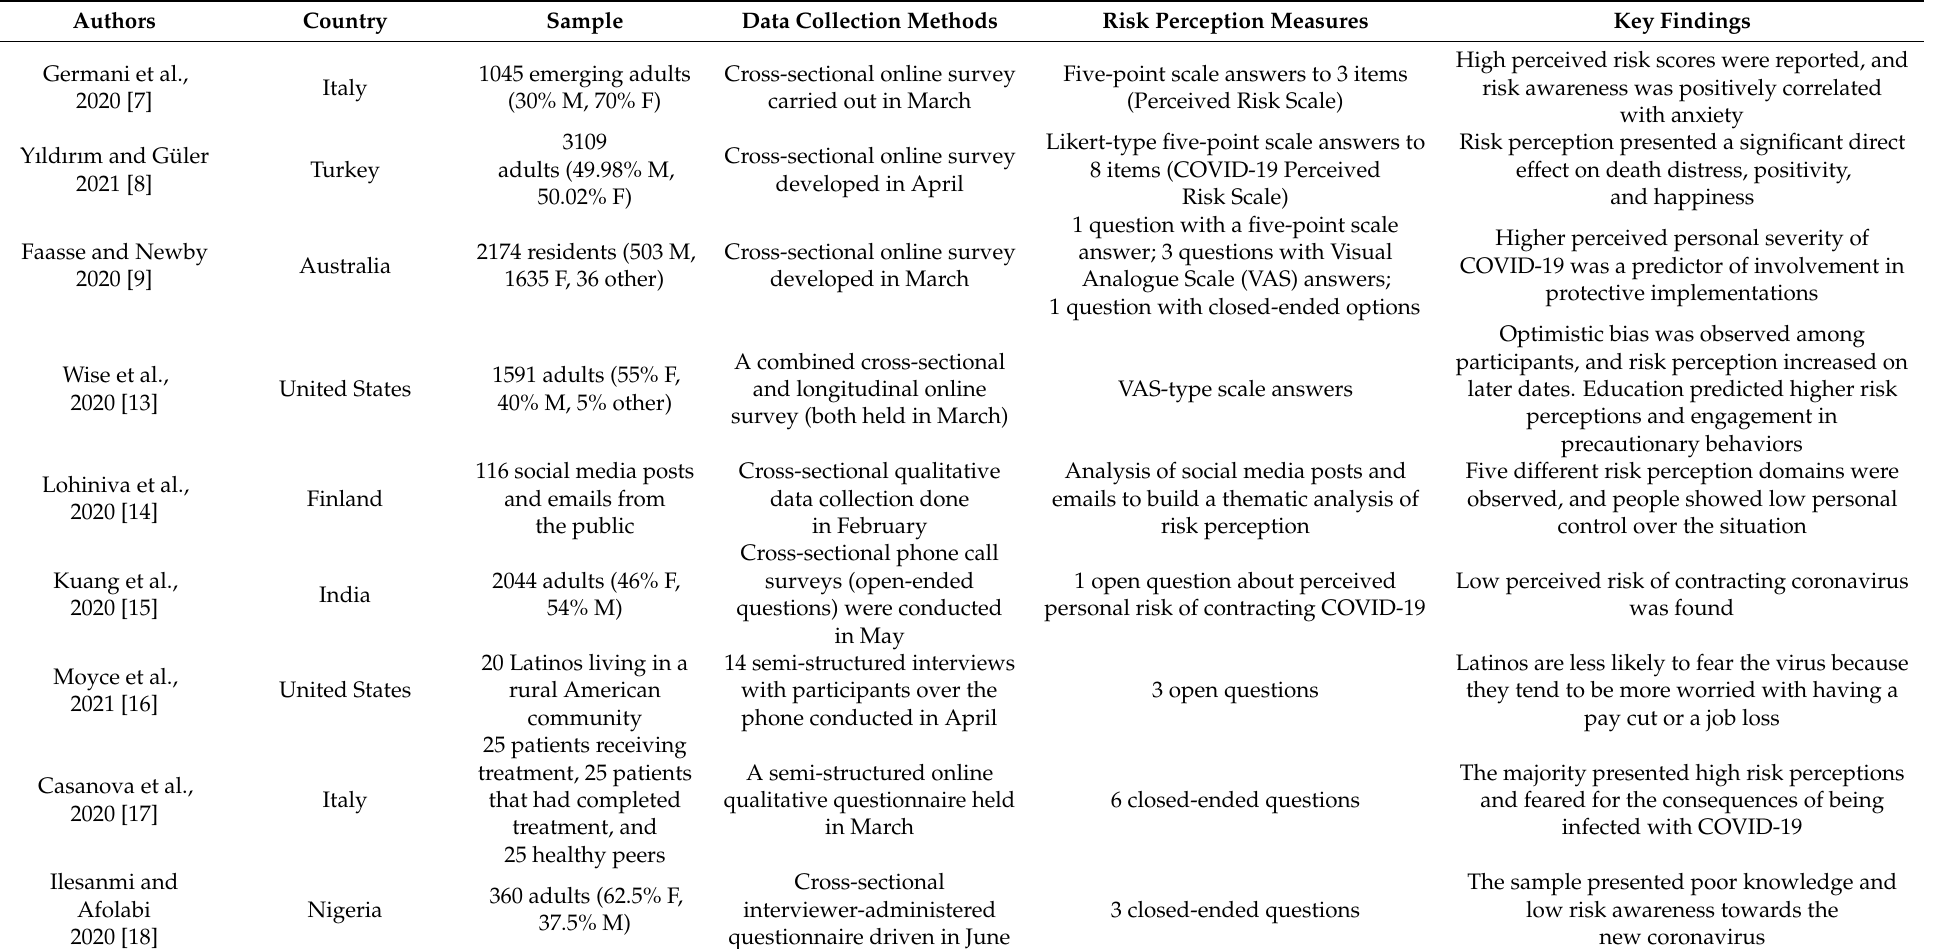
Table A1. Comparative appraisal of the